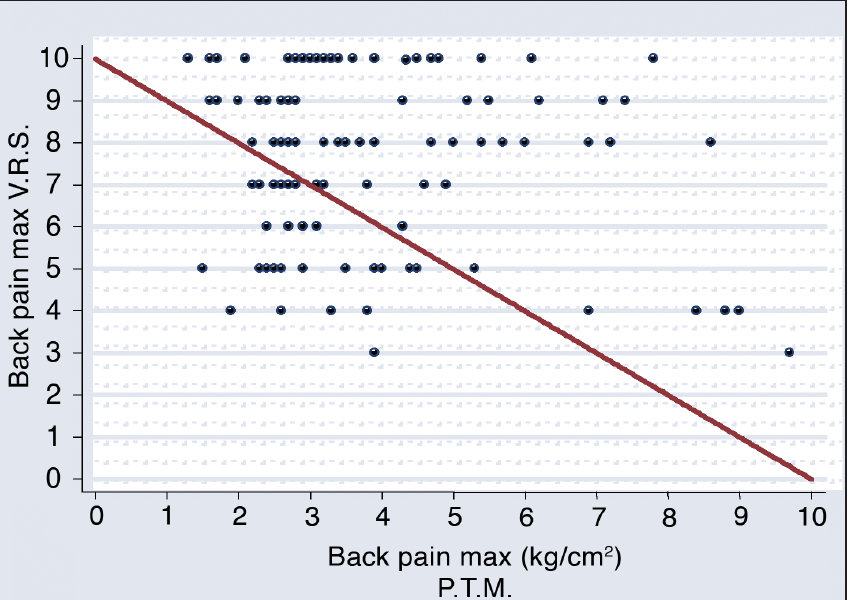
Figure 3: Scatter plot of the maximum pressure pain vs the patient perception on the V.R.S.